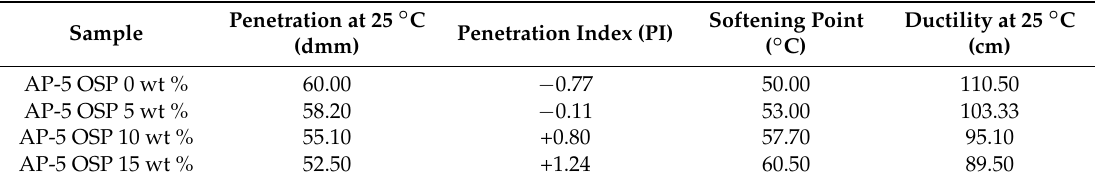
Table 4. Physical properties of unfilled and OSP-filled